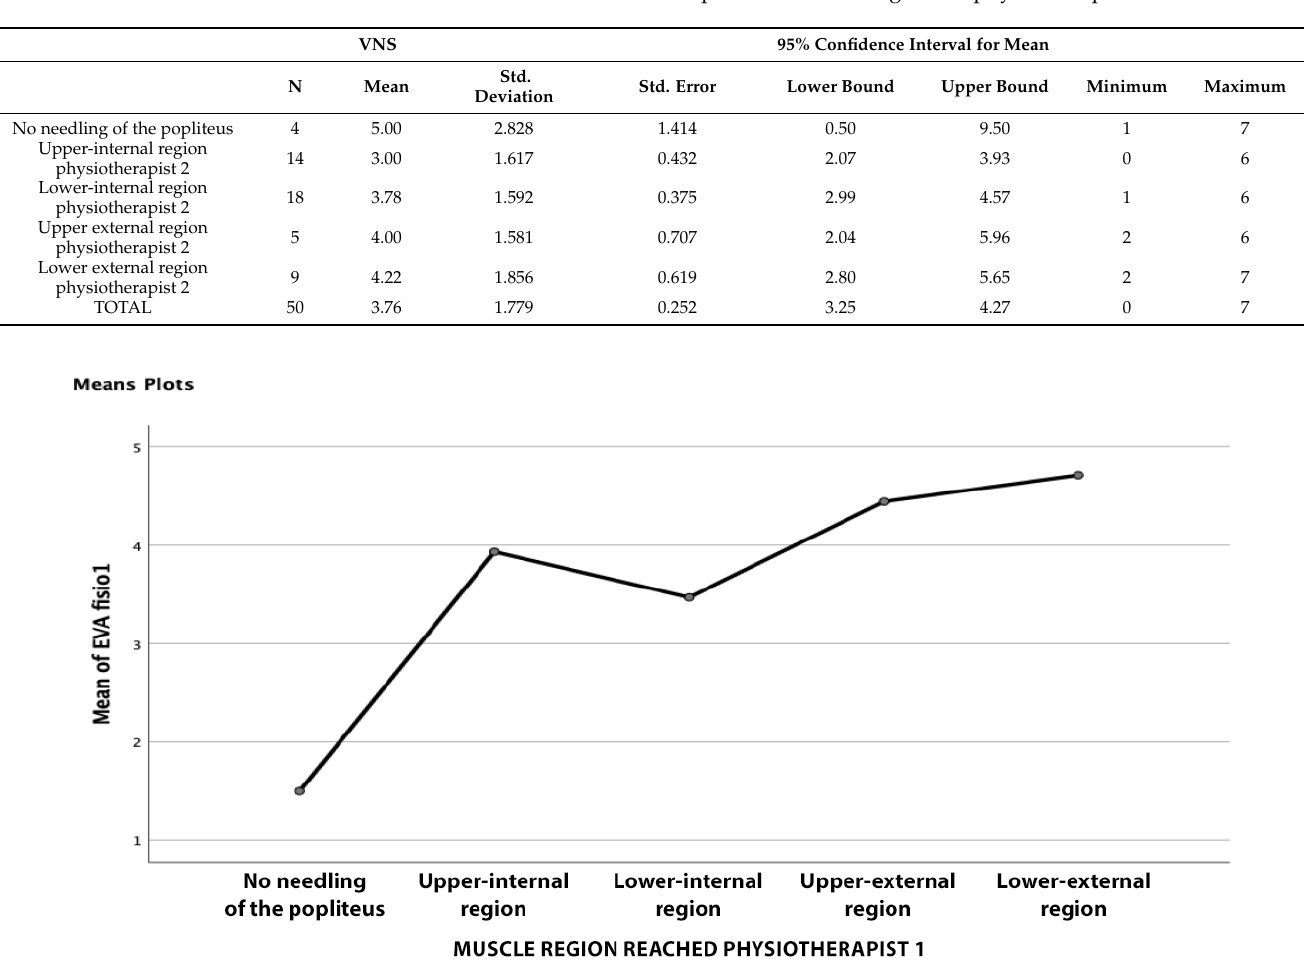
Table 6. Correlation data between the pain and muscle region for physiotherapist 2.